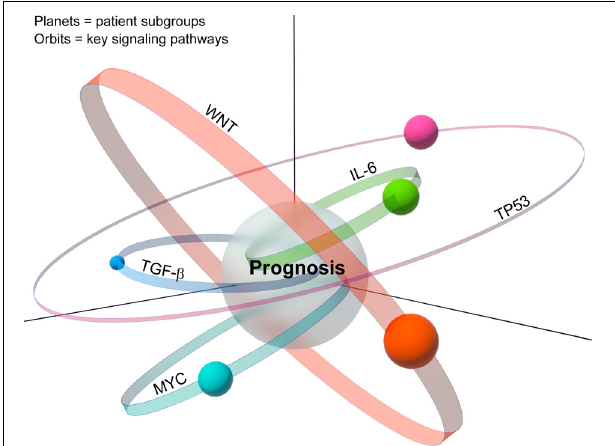
FIGURE 2 | A model depicts the relationship between the biological space and the prognostic space. Multiple patient subgroups exist because of tumor heterogeneity. Analogous to planets, various patients’ subgroups reside on orbits, each of which carries key unique signaling pathways. Representative altered signaling pathways such as MYC, TP53, etc, are indicated. The patients’ subgroups whose orbits intersect with the prognostic space are considered those with similar prognostic